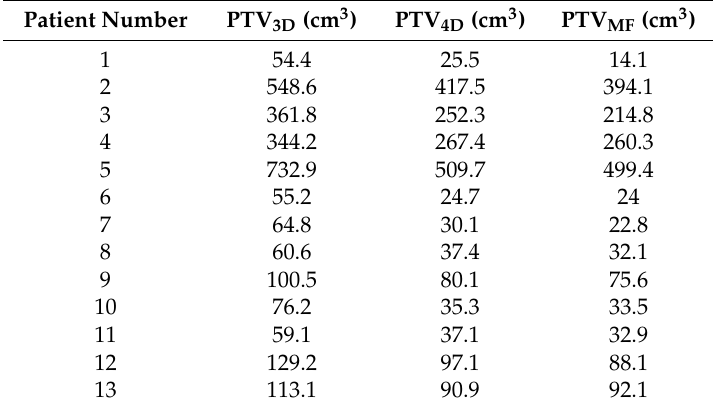
Table 4. Planning target volumes (PTVs) delineated in different treatment